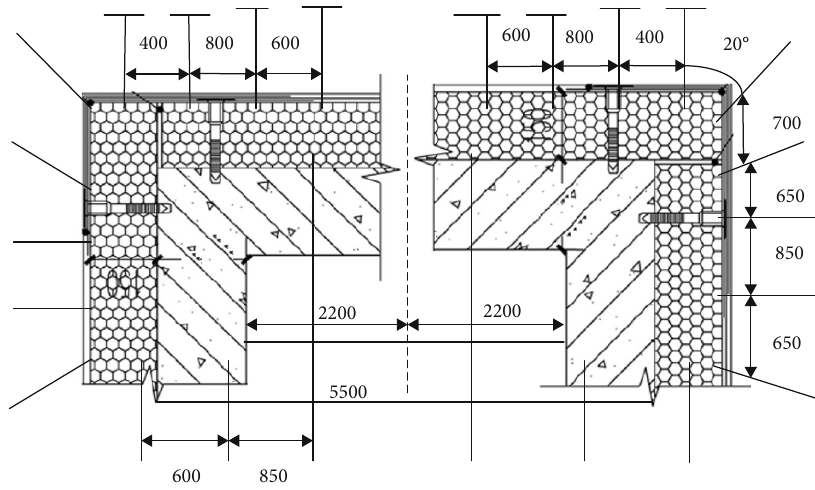
Figure 5: Support plan after optimization of the lower coal seam